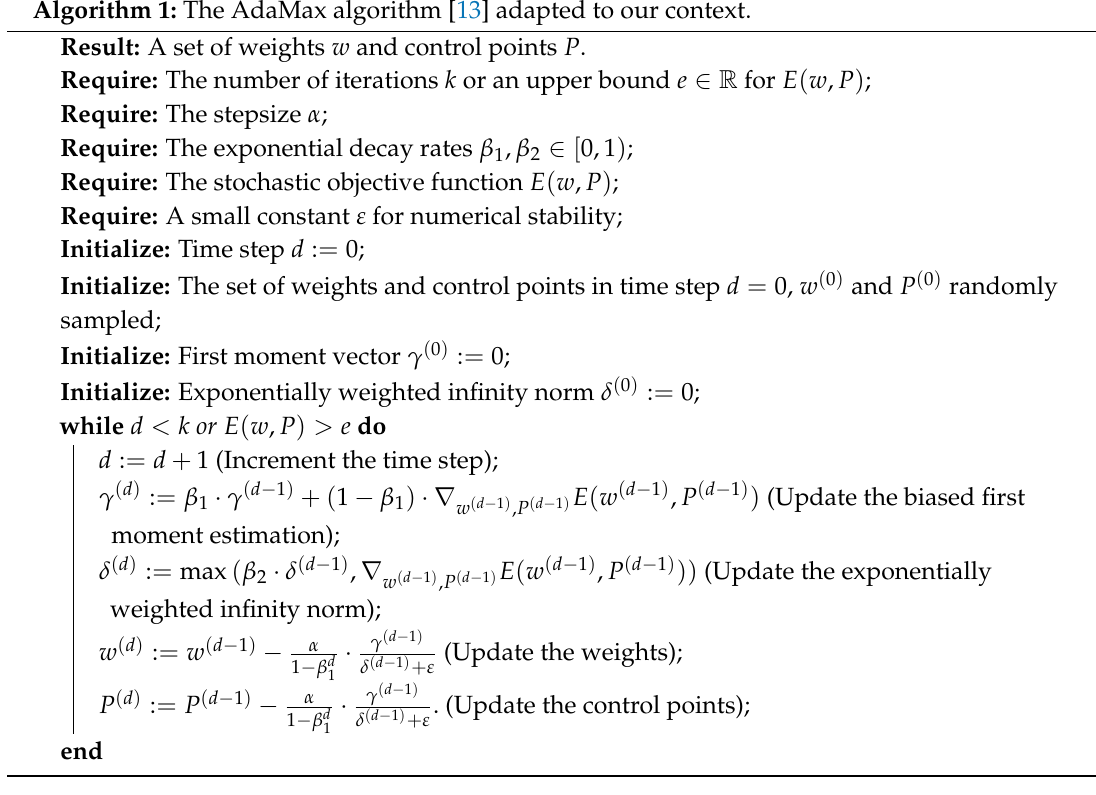
Algorithm 1: The AdaMax algorithm [13] adapted to our context. Result: A set of weights w and control points P